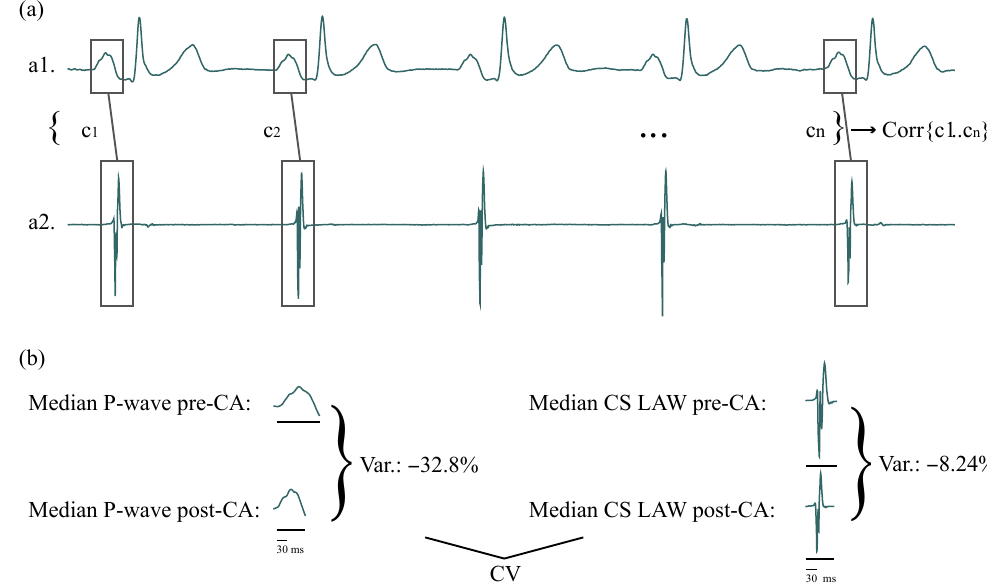
Figure 1. ( a ) Representation of how correlations between features of each P-wave (a1) and CS LAW (a2) of one patient are computed. ( b ) CV of the same patient, example shown for Duration , for recordings before and after CA. Variation due to CA in Duration is calculated for surface ( left ) and invasive ( right ) recordings. Correlation between the surface and invasive variations is then calculated across the entire patient cohort. CS: coronary sinus; LAW: local activation wave; CV: correlation of variation; CA: catheter